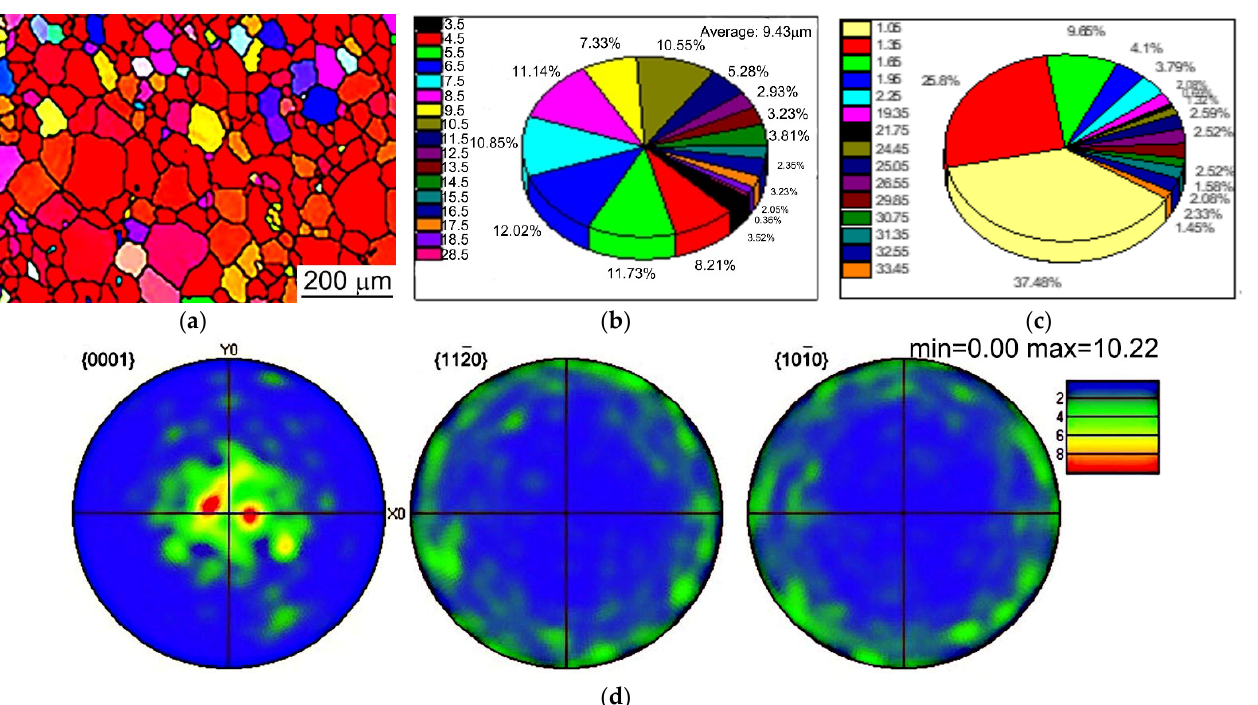
Figure 7. EBSD results of base metal. ( a ) Orientation image; ( b ) Grain size; ( c ) Misorientation angle; ( d ) Pole figure.